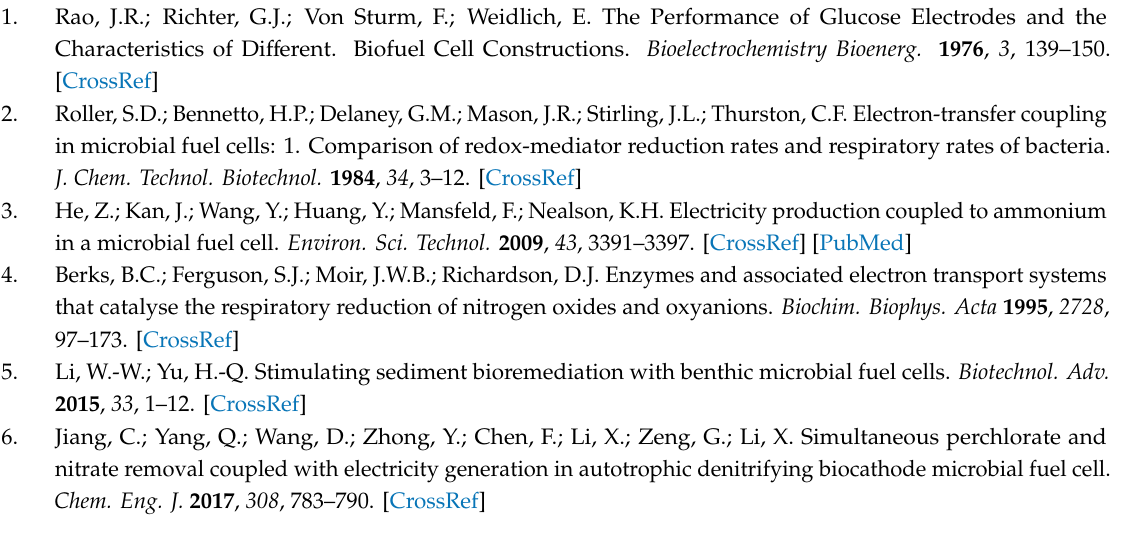
Figure S1: Epifluorescence microscopy of each treatment, using acridine orange 0.1% w / v. When an acridine orange binds with DNA, it will exhibit a green color, and when it binds with RNA, it will exhibit a red color. (A) + 310 mV vs. Ag / AgCl, (B) − 150 mV vs. Ag / AgCl, (C) + 100 mV vs. Ag / AgCl, and (D) Control. All images are in 10 × magnification, Figure S2: Scanning Electron Microscopy of each treatment. (A) + 310 mV vs. Ag / AgCl, (B) − 150 mV vs. Ag / AgCl, (C) + 100 mV vs. Ag / AgCl, and (D) Control. Bar scale represents a size of 2 µ m. The magnifications of these images are 13,900 × , Figure S3: Relative abundance (%) of Marinobacter sp. and Labrenzia sp. in each sample, Table S1: Accession number of the clone sequences reported in this investigation and the most closely related organisms, with its accession number, Table S2: Relative abundance (%) of most abundant genre identified by amplicon analysis (AA) and fragment analysis (FA) in each sample ( + 100 mV, − 150 mV, + 310 mV vs. Ag / AgCl and